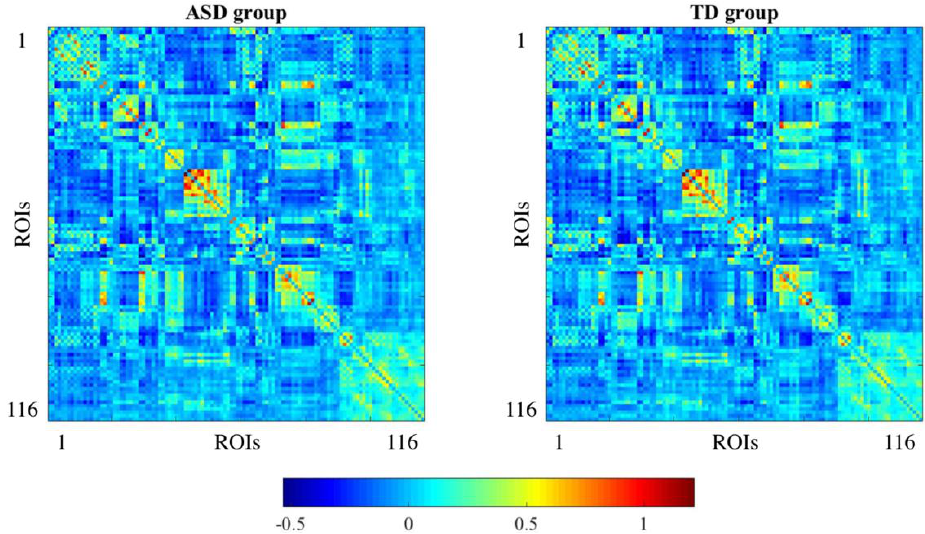
Figure 2. Mean connectivity matrices for ASD and TD groups. Connectivity is obtained using Pearson’s correlation coefficient normalized to Fisher’s z -values. Color scale represents the strength of functional interactions between pairs of ROIs.